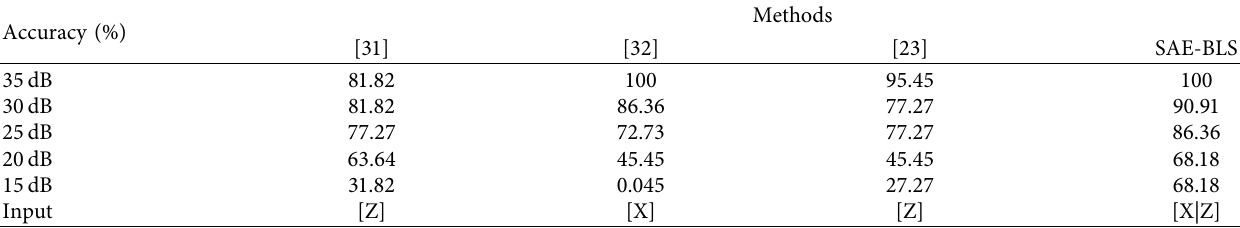
Table 3: Test training